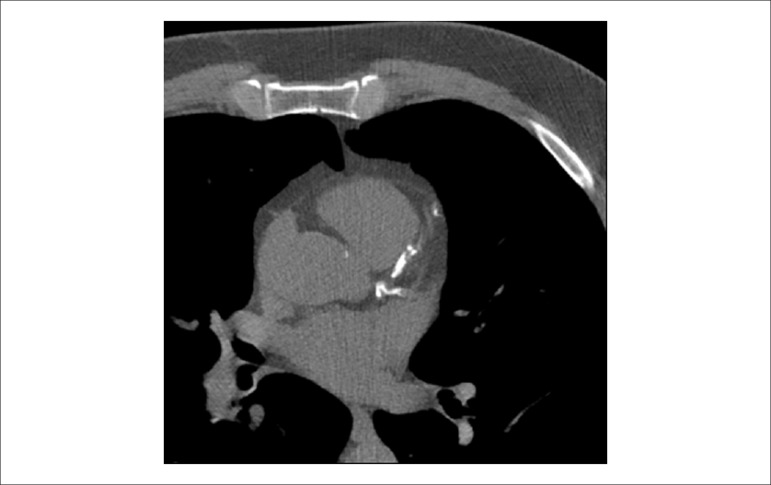
Case 4 - Angio-CT imaging shows elevated calcification index in coronary arteries.